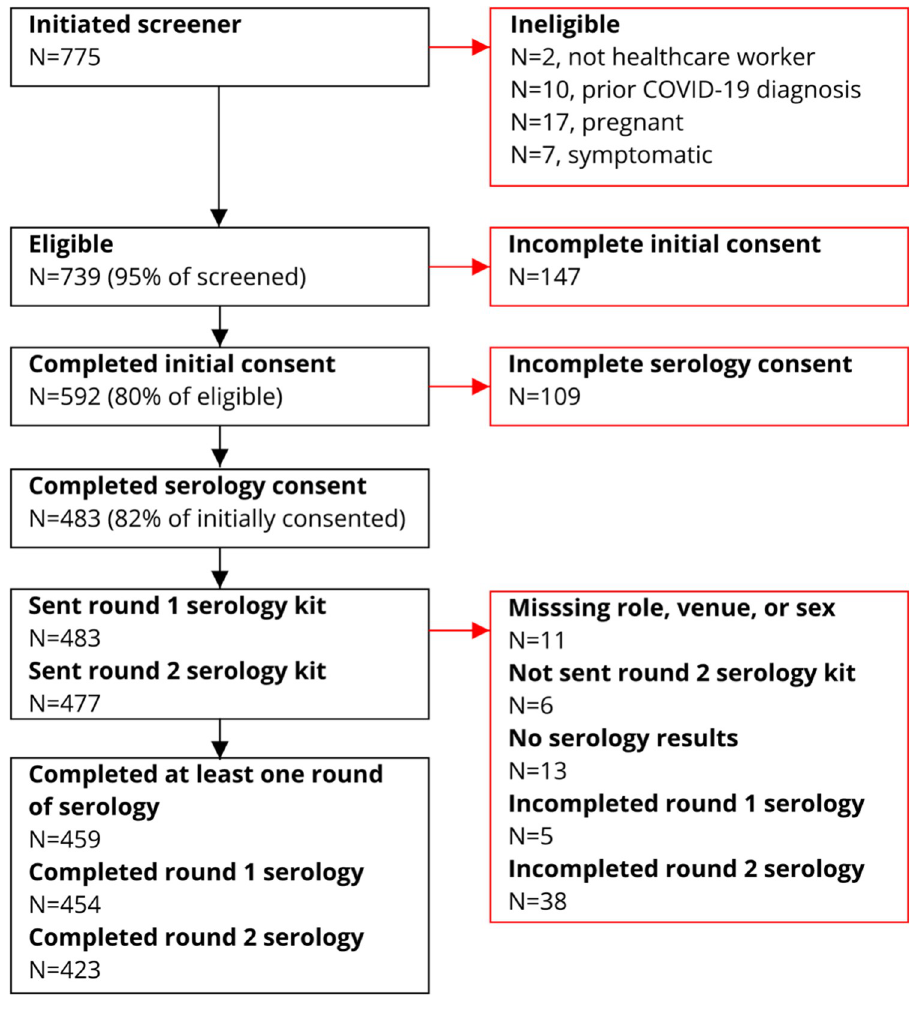
Fig 2. Participant flow